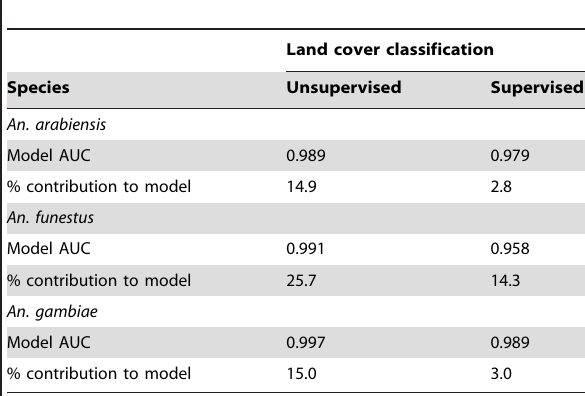
Table 1. Comparison of malaria vector species’ niche models using unsupervised vs. supervised land cover